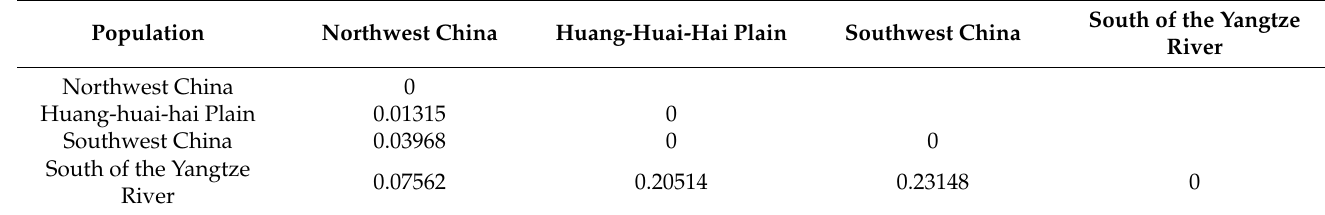
Table 4. Genetic differentiation index ( Fst ) of different populations *.